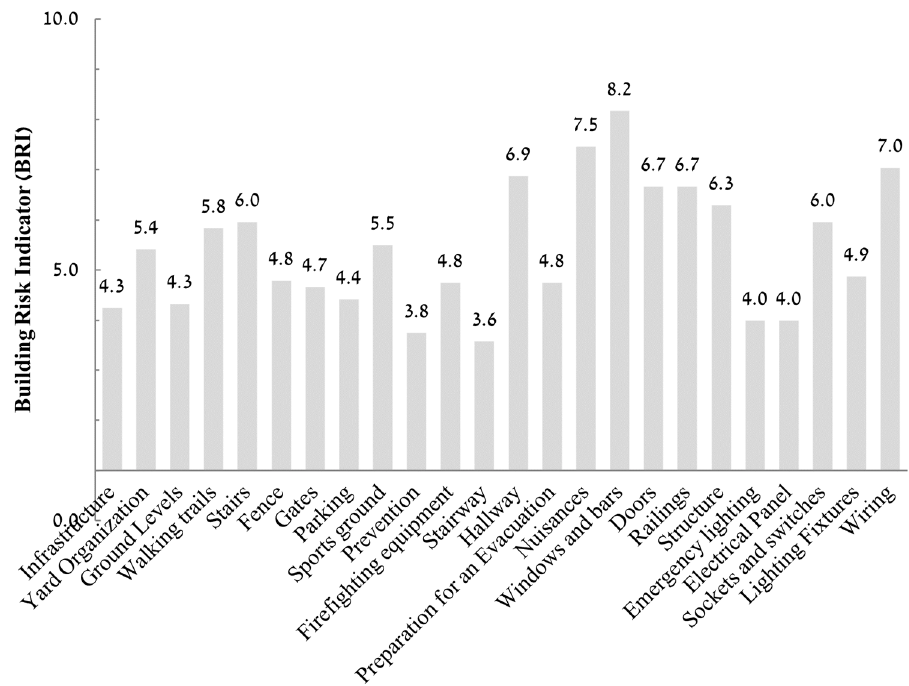
Figure 4. MeanBuildingRiskIndicator(BRI)ineducationalfacilitiessampleaccordingtobuildingsystems. Figure 4. Mean Building Risk Indicator (BRI) in educational facilities sample according to building systems.